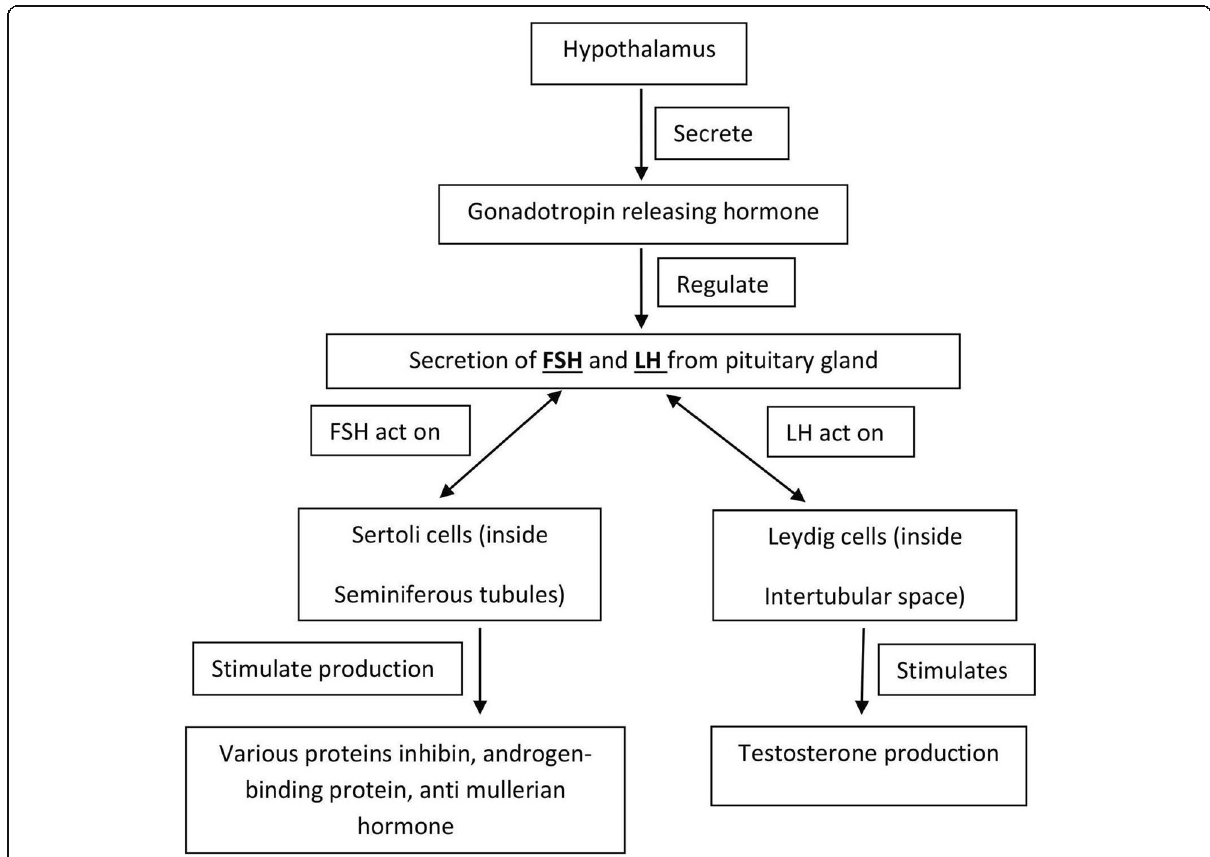
Fig. 2 Release and production of different hormones from